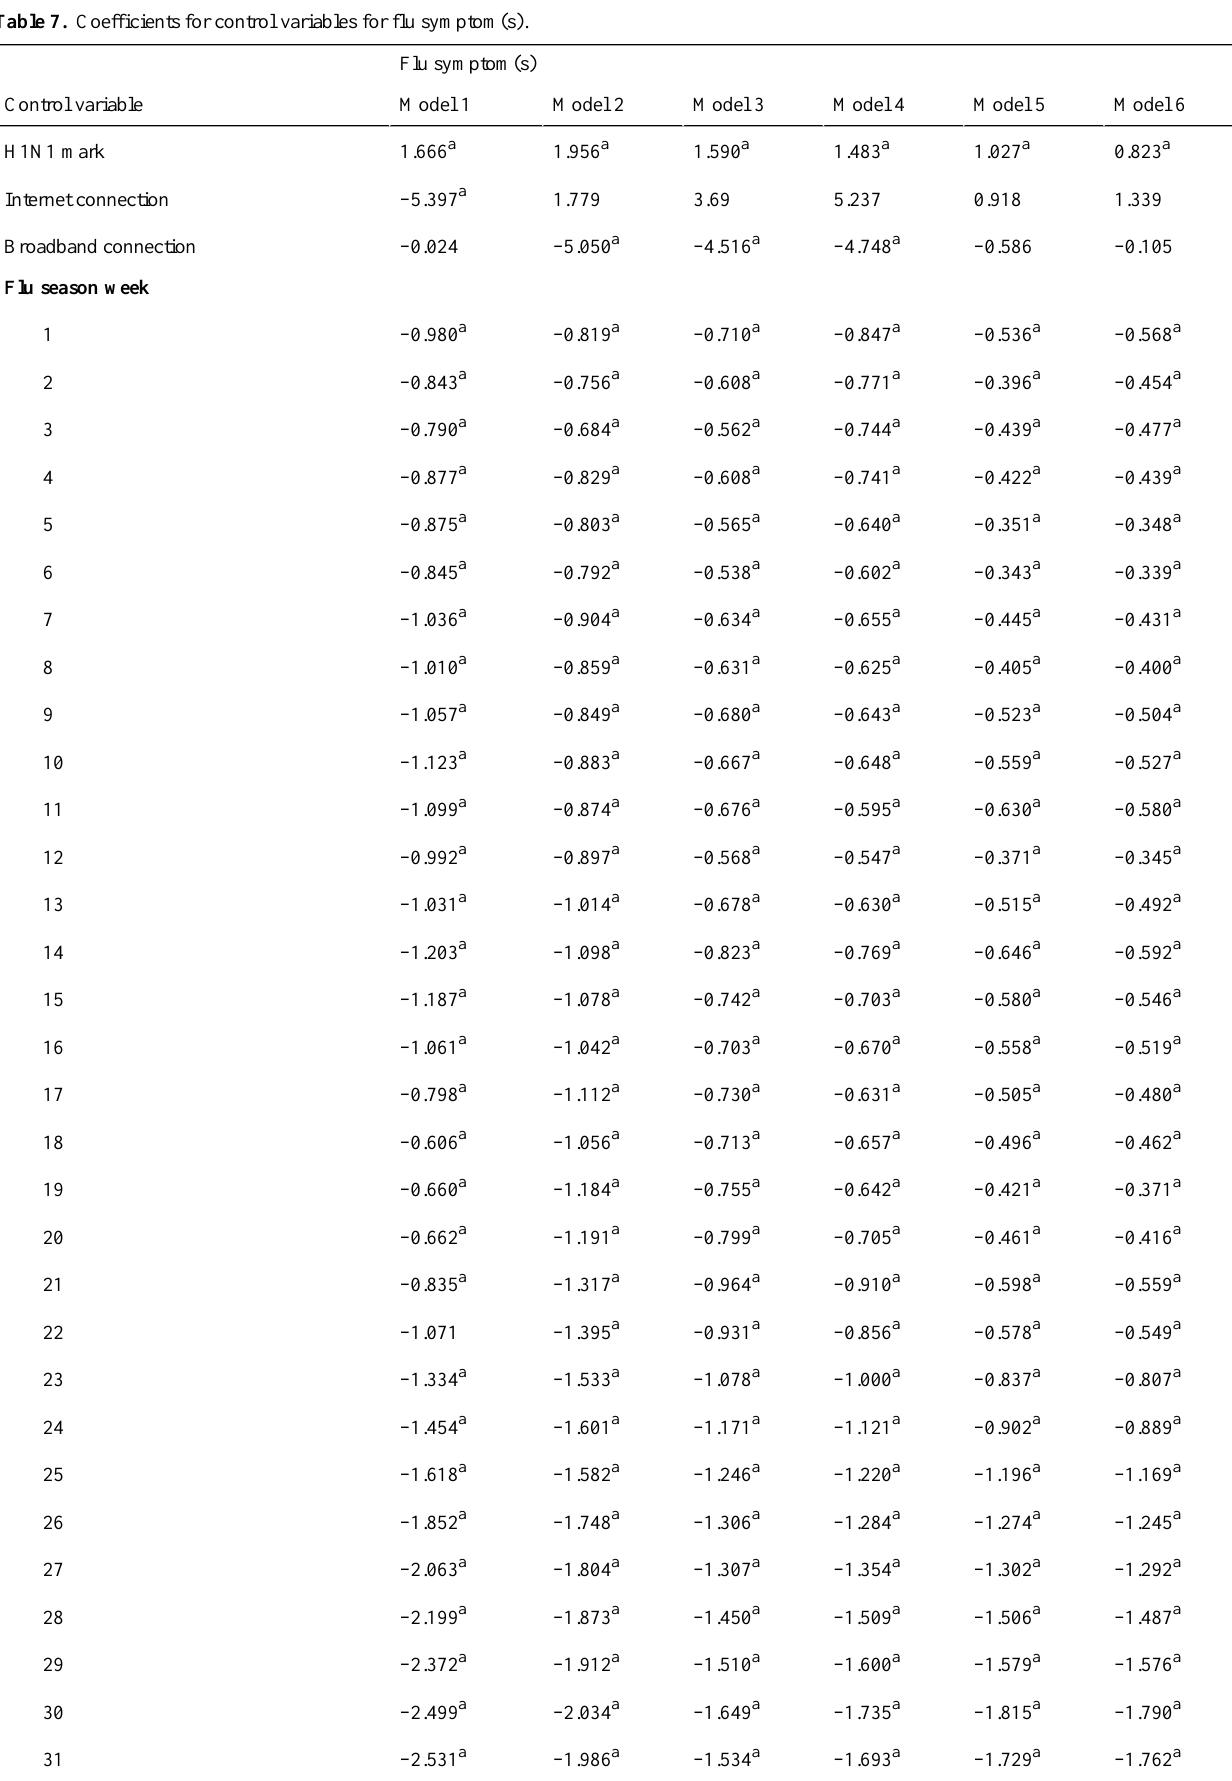
Table 7. Coefficients for control variables for flu